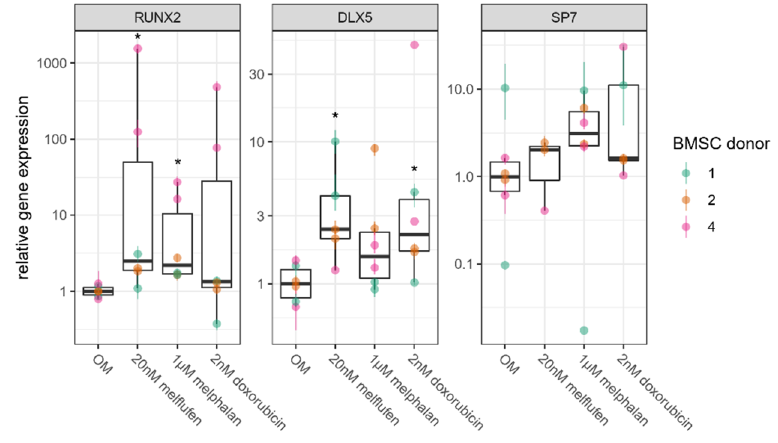
Figure 13. Drug effect on the expression of osteogenic marker genes. Relative expression levels of osteogenic marker genes RUNX2, DLX5 and SP7 in BMSCs at 21 days of culture in osteogenic differentiation conditions with 20 nM melflufen, 1 µM melphalan and 2 nM doxorubicin. Gene expression levels are shown relative to the mean expression in osteogenically differentiated control without drugs (OM). Dots represent individual culture wells with a color-coded donor cell line and crossbars indicating the measured range. * denotes p < 0.05 with Dunn’s test.